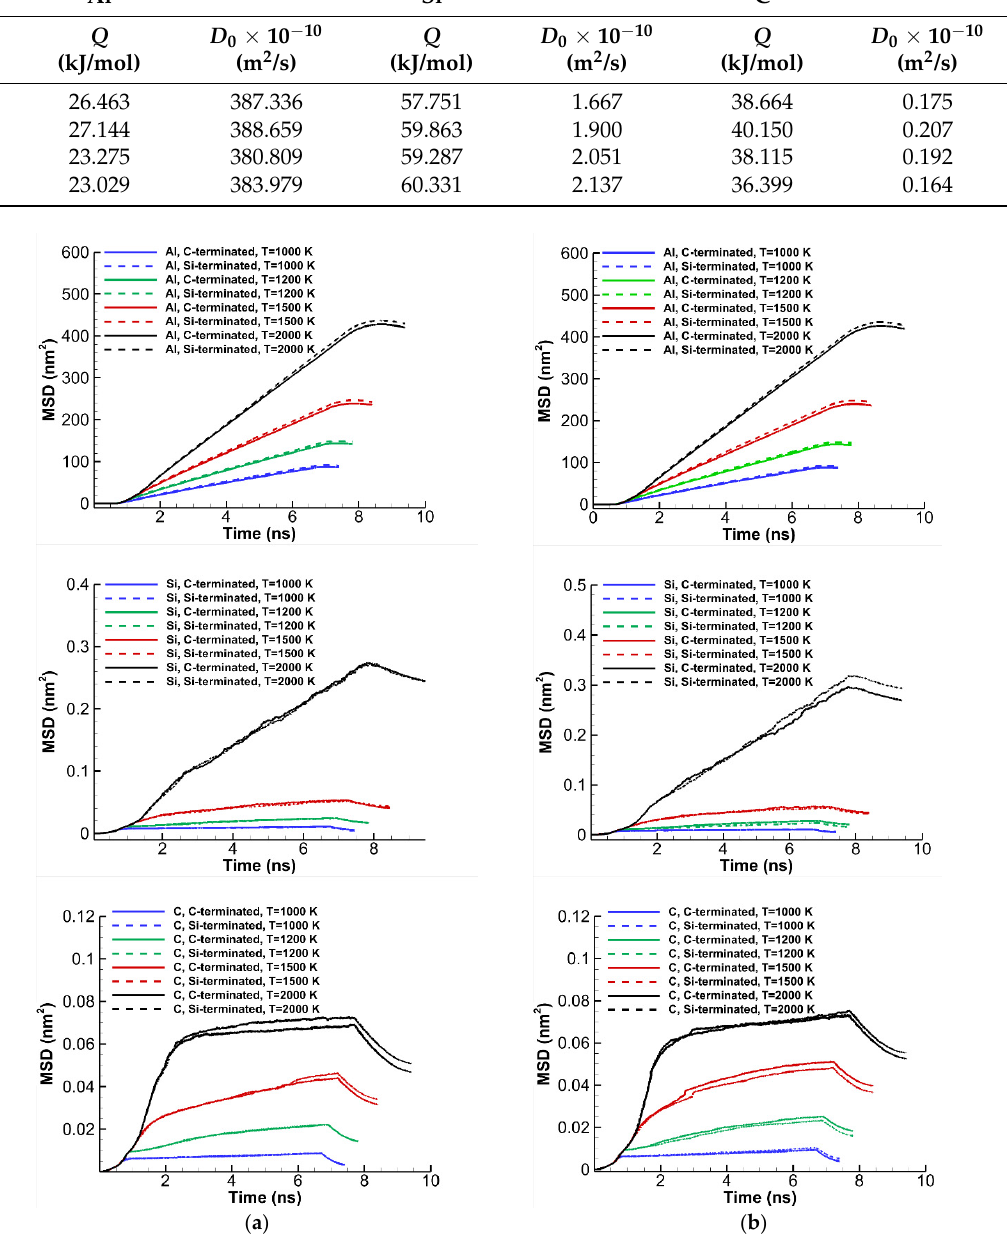
Figure 6. Time histories of the MSD at different temperatures for different atoms of the ternary systems. The C- and Si-terminated ( a ) 6H–SiC/Al interface and ( b ) 3C–SiC/Al interface.